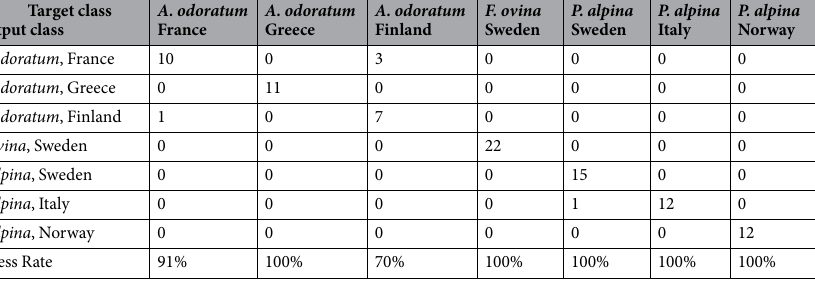
Table 1. Classification results of an independent test set of pollen MALDI-TOF mass spectra using PLS with 9 latent variables for the classification of seven different populations. The numbers in the cells indicate the amount of spectra classified as the respective output